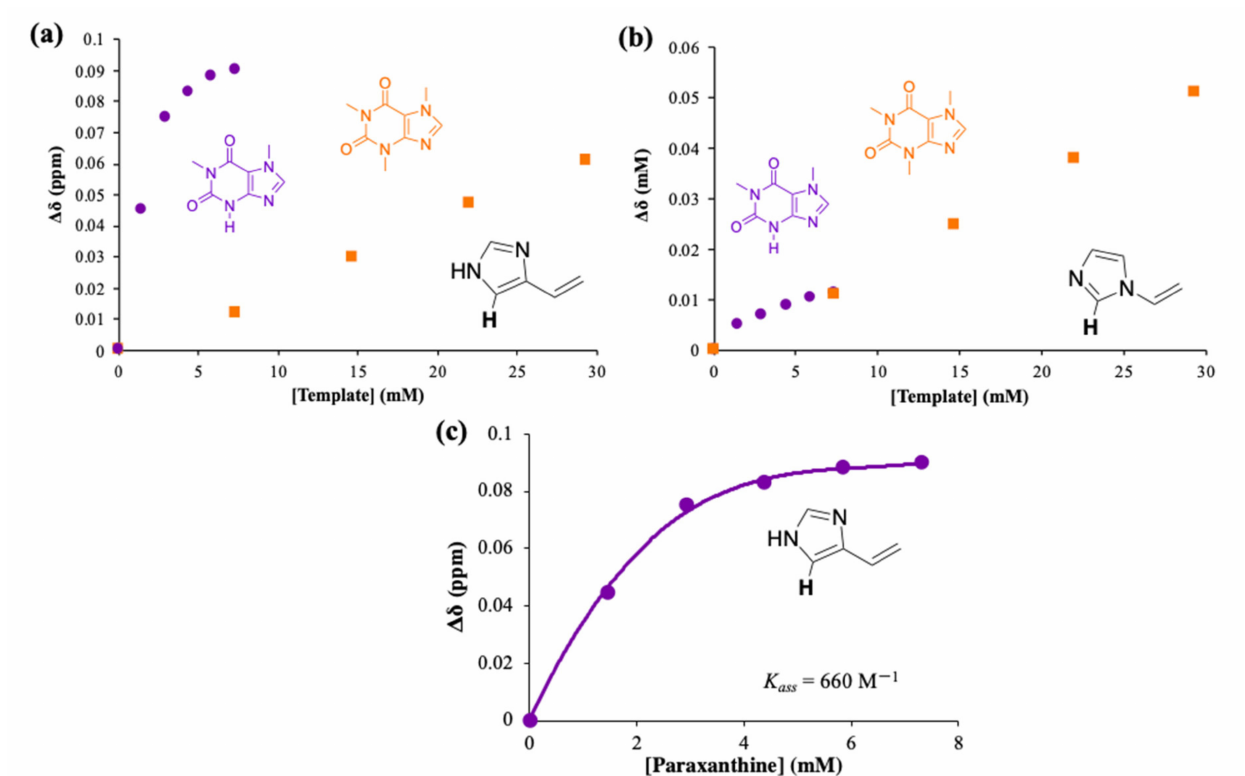
Figure 6. 1 H NMR titration of: ( a ) 4-vinylimidazole with paraxanthine (PX, purple circles) and caffeine (CAF, orange squares) in D 2 O, at 25 ◦ C; ( b ) 1-vinylimidazole with paraxanthine (PX, purple circles) and caffeine (CAF, orange squares) in D 2 O, at 25 ◦ C. ( c ) Variation of the chemical shift of the indicated proton of 4-vinylimidazole upon subsequent addition of PX (0–5 equivalents) in D 2 O, at